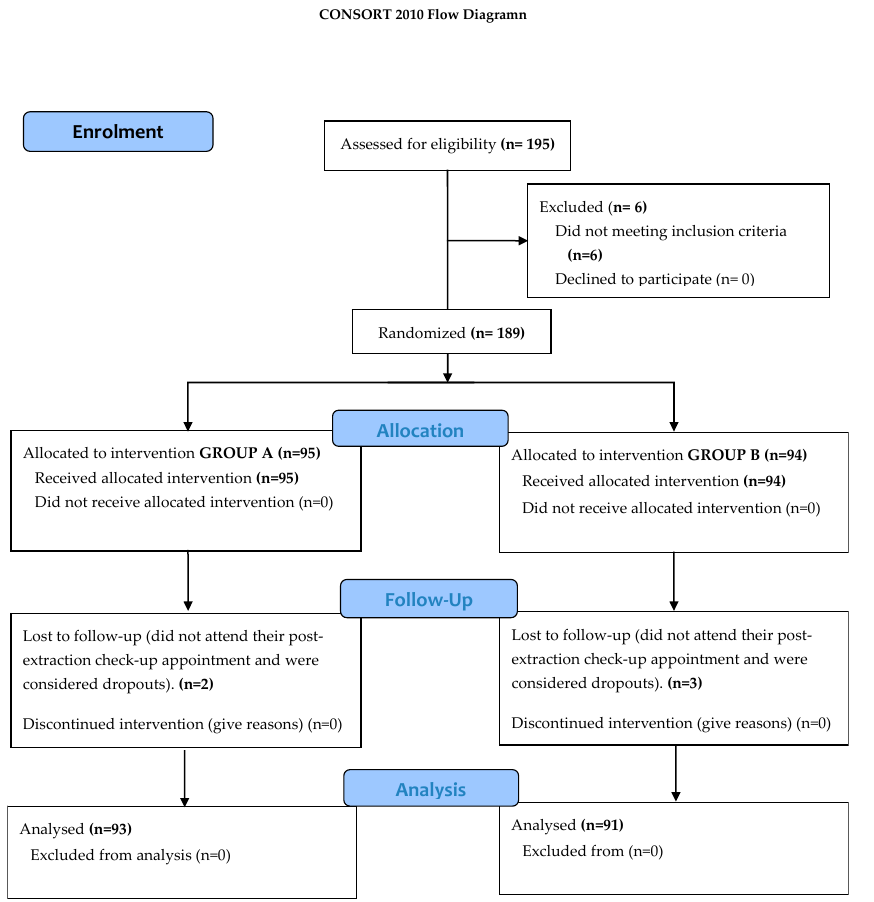
Figure 1. Study design (CONSORT diagram).